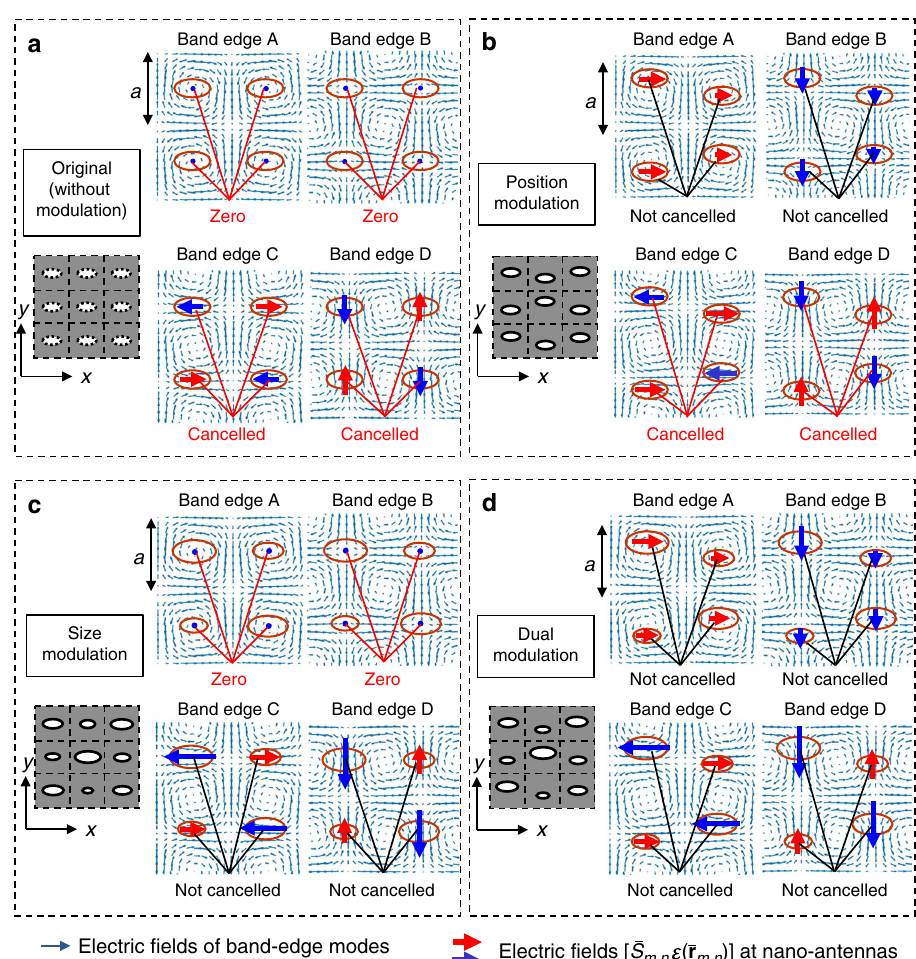
Fig. 2 Elecric fi elds of band-edge modes A – D radiated into free-space by lattice points considered to function as nanoantennas. a – d Electric- fi eld distributions of band-edge modes A – D in a photonic crystal a without modulation and with b position modulation, c size modulation, and d dual modulation . a Far- fi eld radiation is zero for all modes, due to the rotationally symmetric electric fi eld of band-edge modes A and B with respect to the lattice points and the opposing electric- fi eld vectors of band-edge modes C and D. b Far- fi eld radiation is fi nite for band-edge modes A and B due to their fi nite electric- fi eld vectors pointing in identical directions, and near-zero for band-edge modes C and D due to their fi nite electric- fi eld vectors pointing in opposite directions. c Far- fi eld radiation is zero for band-edge modes A and B, for the same reason as in a , and fi nite for band-edge modes C and D, due to the alleviation of destructive interference. d Far- fi eld radiation is fi nite for all modes, due to the combined effects of position and size modulations. In each panel, the product of the size (cid:1) S m ; n of each nanoantenna and the electric- fi eld Eð (cid:1) r m ; n Þ at its center position (cid:1) r m ; n is shown with blue and red arrows. When the product becomes zero, only dots are